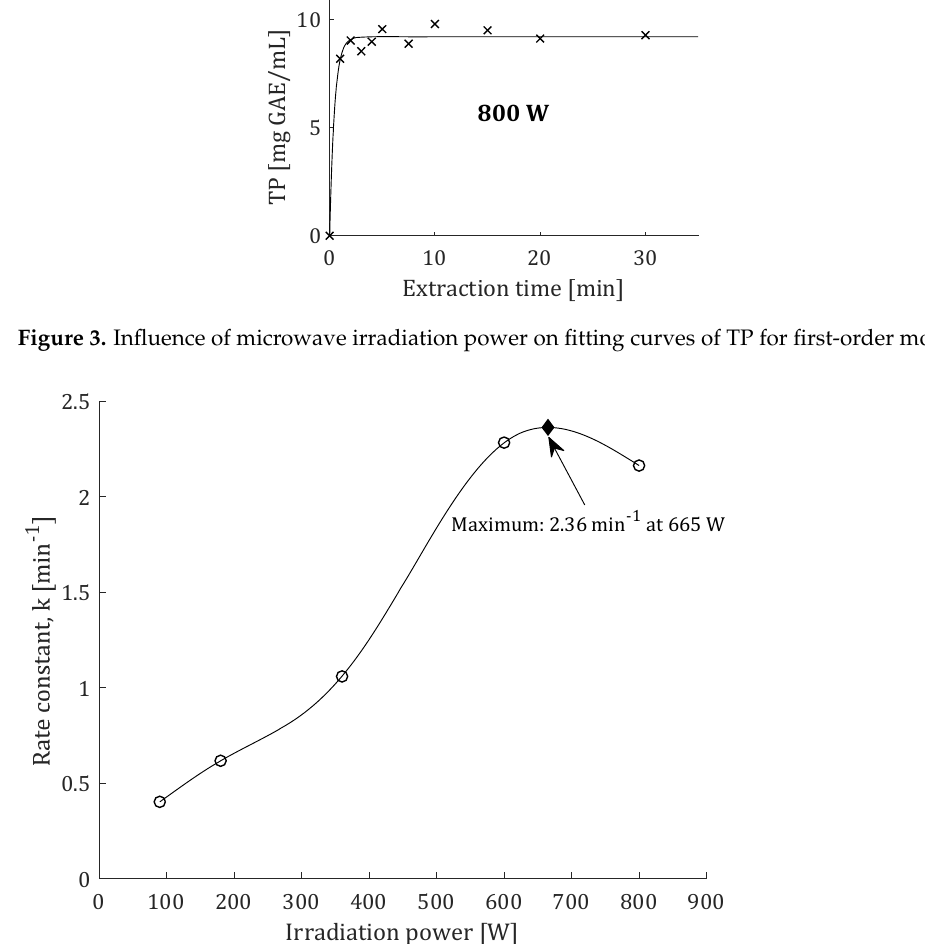
Figure 4. Influence of microwave irradiation power extraction rate constant ( k 1 ) calculated from Model I.